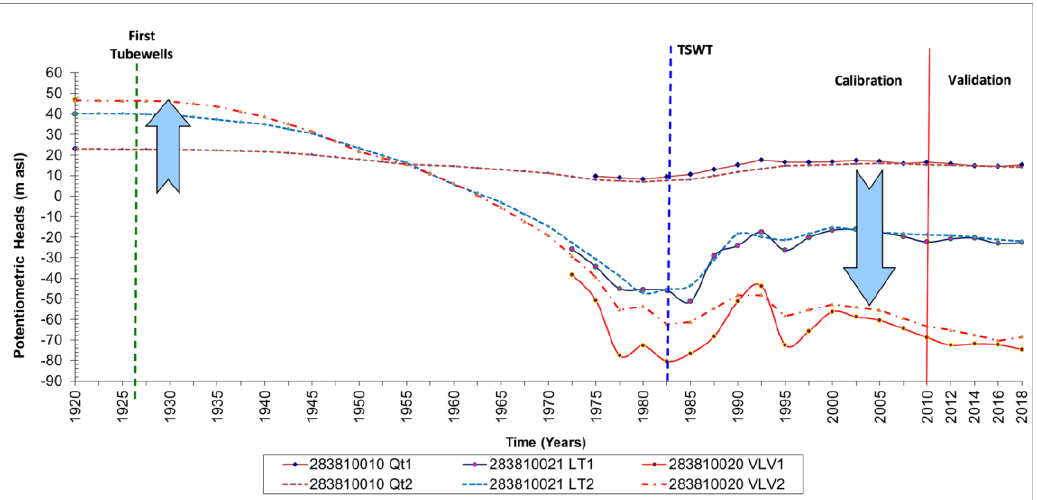
Figure 9. Long-term piezometric evolution of groundwater in a transient state, comparing the observed and calculated hydraulic heads in the San Javier area. 283810010 Qt: Quaternary aquifer layer; 283810021 Lt: Pliocene aquifer layer; 283810020 VLV: Messinian aquifer layer. For the period between the 1928 and 1975 piezometric observations, the values are estimated. Thus, Qt1, LT1 and VLV1 are observed, and Qt2, LT2 and VLV2 are calculated.